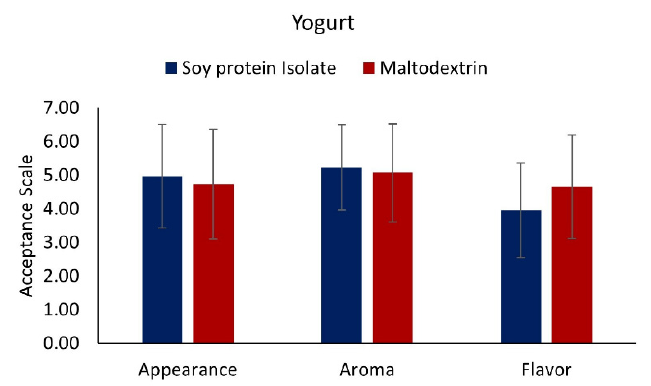
Figure 4. Sensory evaluation of yogurt with added muicle extract MD and SPI microcapsules. 1 = Dislike Very Much, 2 = Dislike Moderately, 3 = Dislike Slightly, 4 = Neither like nor dislike, 5 = Like Slightly, 6 = Like Moderately, 7 = Like Very Much.